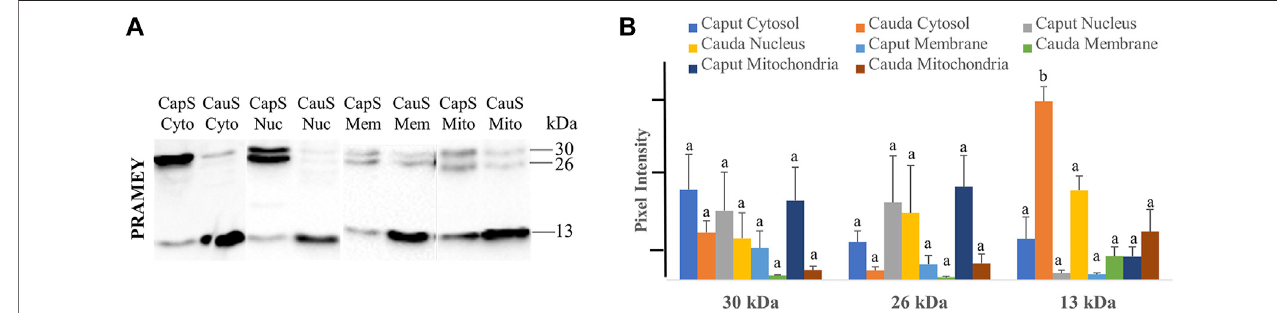
FIGURE 7 | Expression of PRAMEY isoforms in the following subcellular compartments: caput sperm cytosol (CapS Cyto), cauda sperm cytosol (CauS Cyto), caput sperm nucleus (CapS Nuc), cauda sperm nucleus (CauS Nuc), caput sperm membrane (CapS Mem), cauda sperm membrane (CauS Mem), caput sperm mitochondria (CapS Mito), and cauda sperm mitochondria (CauS Mito). (A) Immunoblot of total subcellular compartment protein in each group probed by PRAMEY antibody. (B) Quanti fi cation of pixel intensities for the 30, 26, and 13 kDa PRAMEY bands. Data are expressed as the mean of the protein pixelintensity ±SEM ( n = 3). Signi fi cance was evaluated between the eight types of subcellular compartments (cytosol, nucleus, membrane, and mitochondria from caput and cauda sperm) for each PRAMEY isoform (30, 26, and 13 kDa). Values without a common superscript differed ( p <